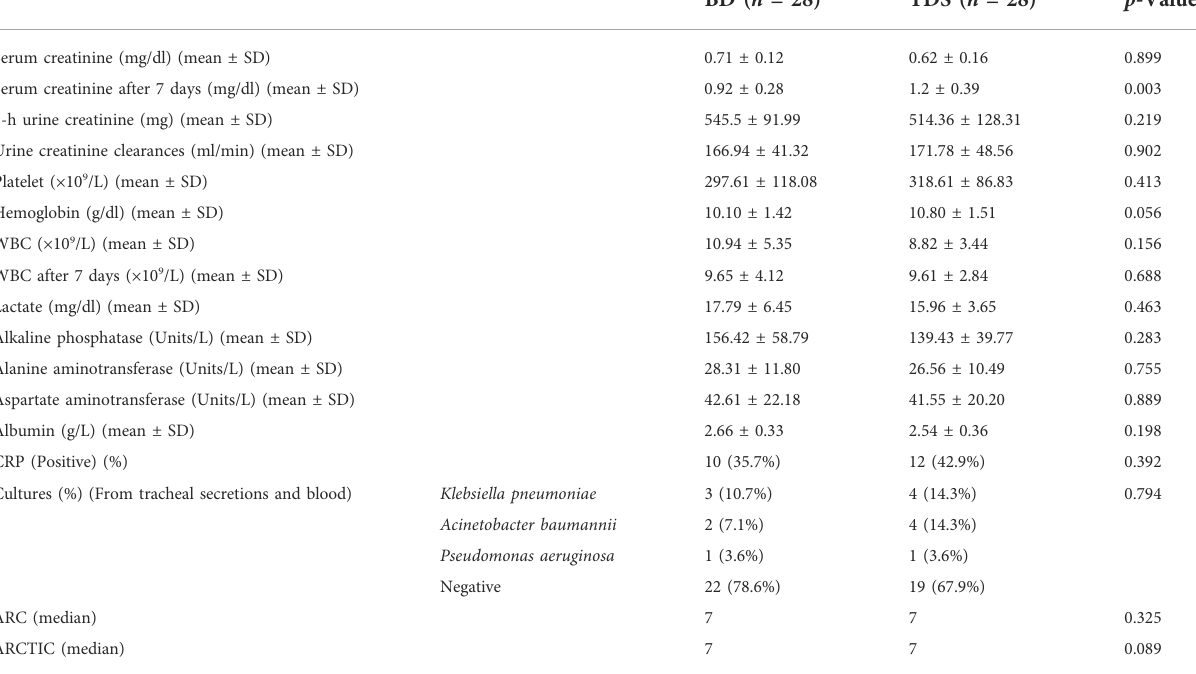
TABLE 3 Laboratory fi ndings as well as ARC and ARCTIC scores of both